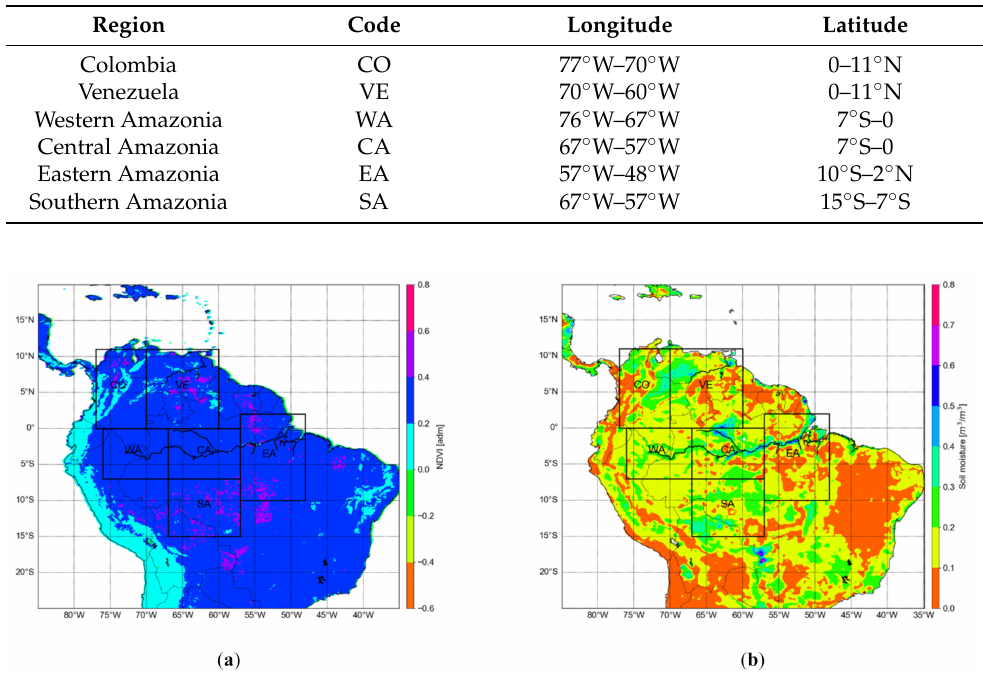
Figure 1. Long-term mean maps of: ( a ) normalized difference vegetation index (NDVI); ( b ) soil moisture